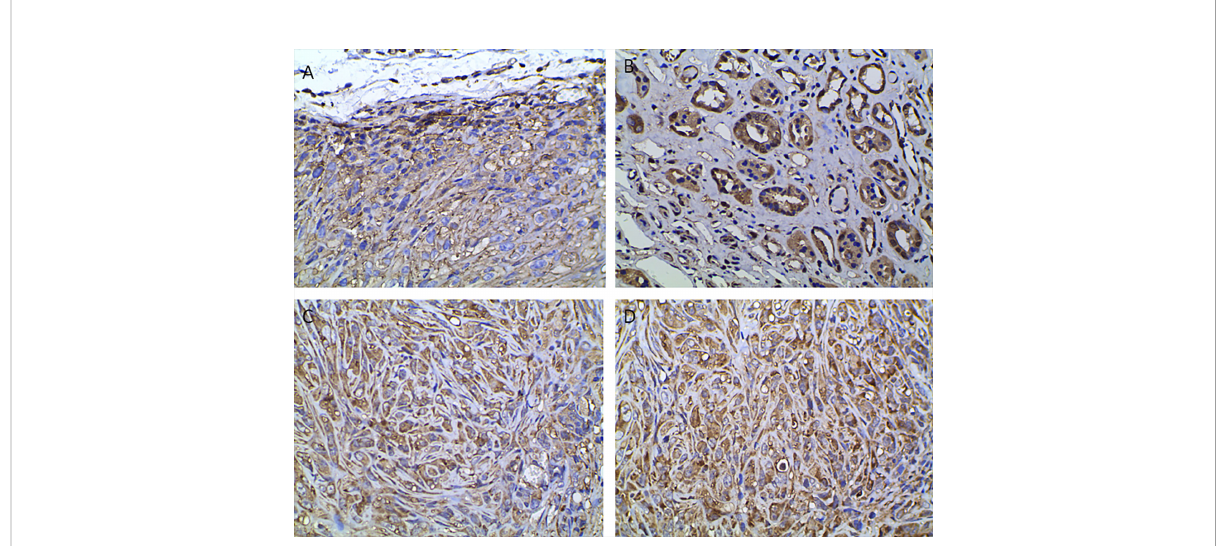
FIGURE 4 Immunohistochemical analysis indicating positive staining for enzymes associated with glucose metabolism and VHL. (A) GLUT1, (B) HK2, (C) LDHA, (D) VHL (400× magni fi